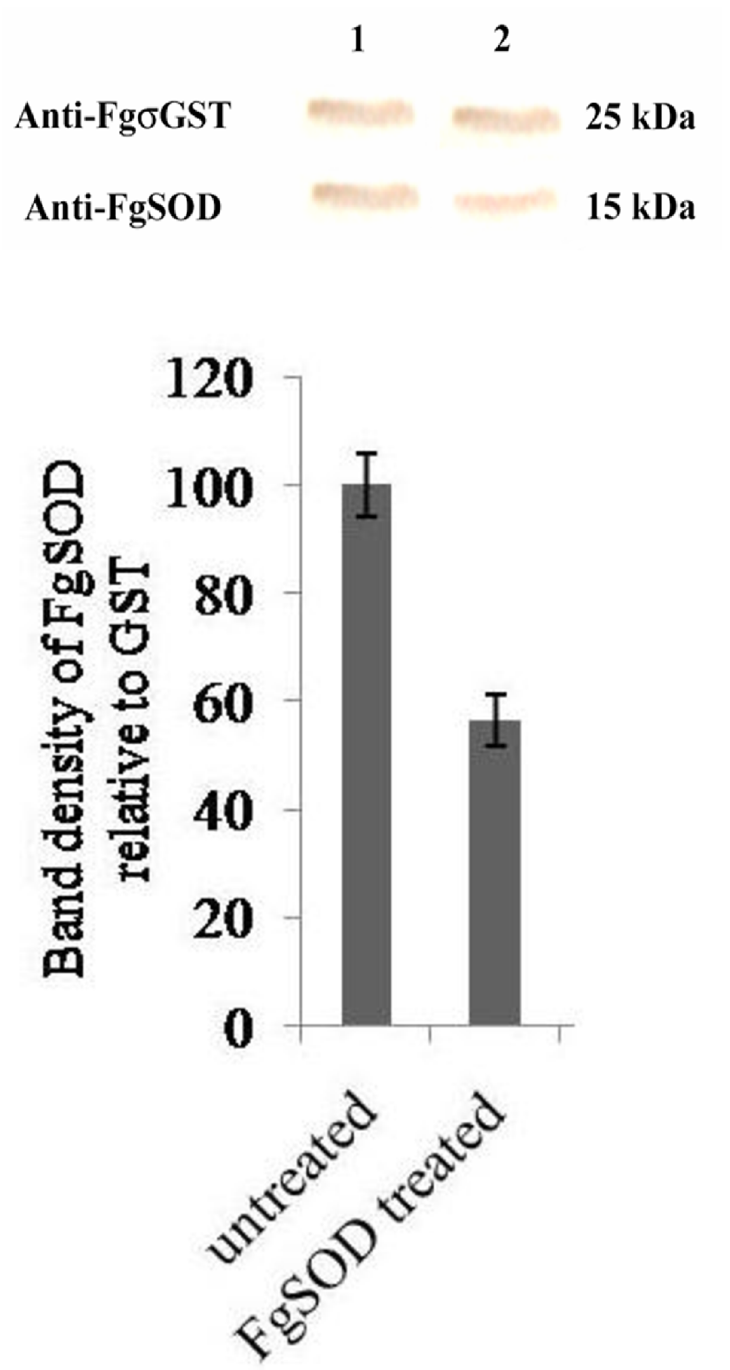
Fig 6. Western blot analysis of F . gigantica SOD protein suppression by SOD specific dsRNA treatment. Densitometry analysisof protein bandsgeneratedby immunoblot of NEJs crude protein extract at 9 days post-exposure to SOD specific long dsRNA. Upper panel: σ GST antiserum probedbands(25kDa)in untreated (1) and dsRNA treated flukes (2). Lower panel: SOD antiserumprobedbands (15kDa)in untreated (1) and dsRNA treated flukes (2). Bar graphs illustrate densitometric analysesof western blot protein bands, where target band density is normalized to loadingcontrol band density and expressedrelative to untreated sample (where untreated control = 100%). Statistical significanceis indicatedrelative to the effects of untreated control. Experiments were repeated3 times. Significantdifferences betweendsRNA treated